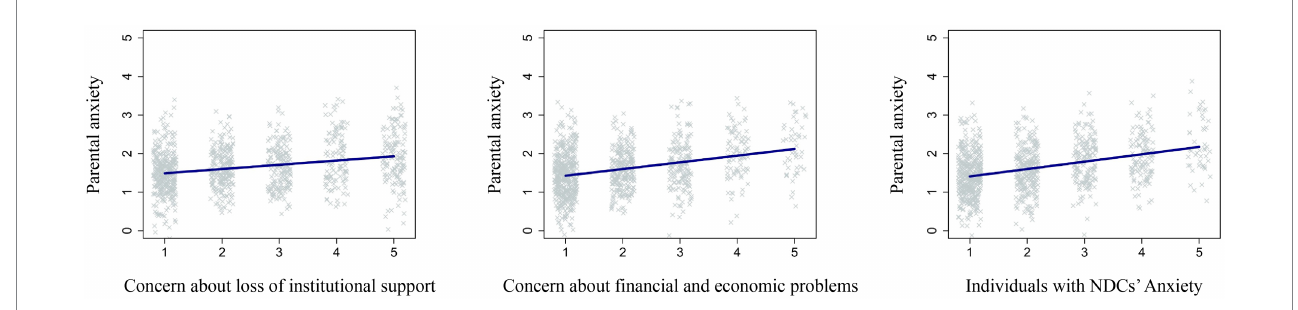
FIGURE 2 Continuous main positive effects of concern about loss of institutional support, concern about financial and economic problems and children with NDCs’ anxiety on parental anxiety. Anxiety and concerns are measured with a 5-point Likert scale from 1 (not anxious/not concerned at all) to 5 (very anxious/ extremely concerned). NDCs = neurodevelopmental conditions.